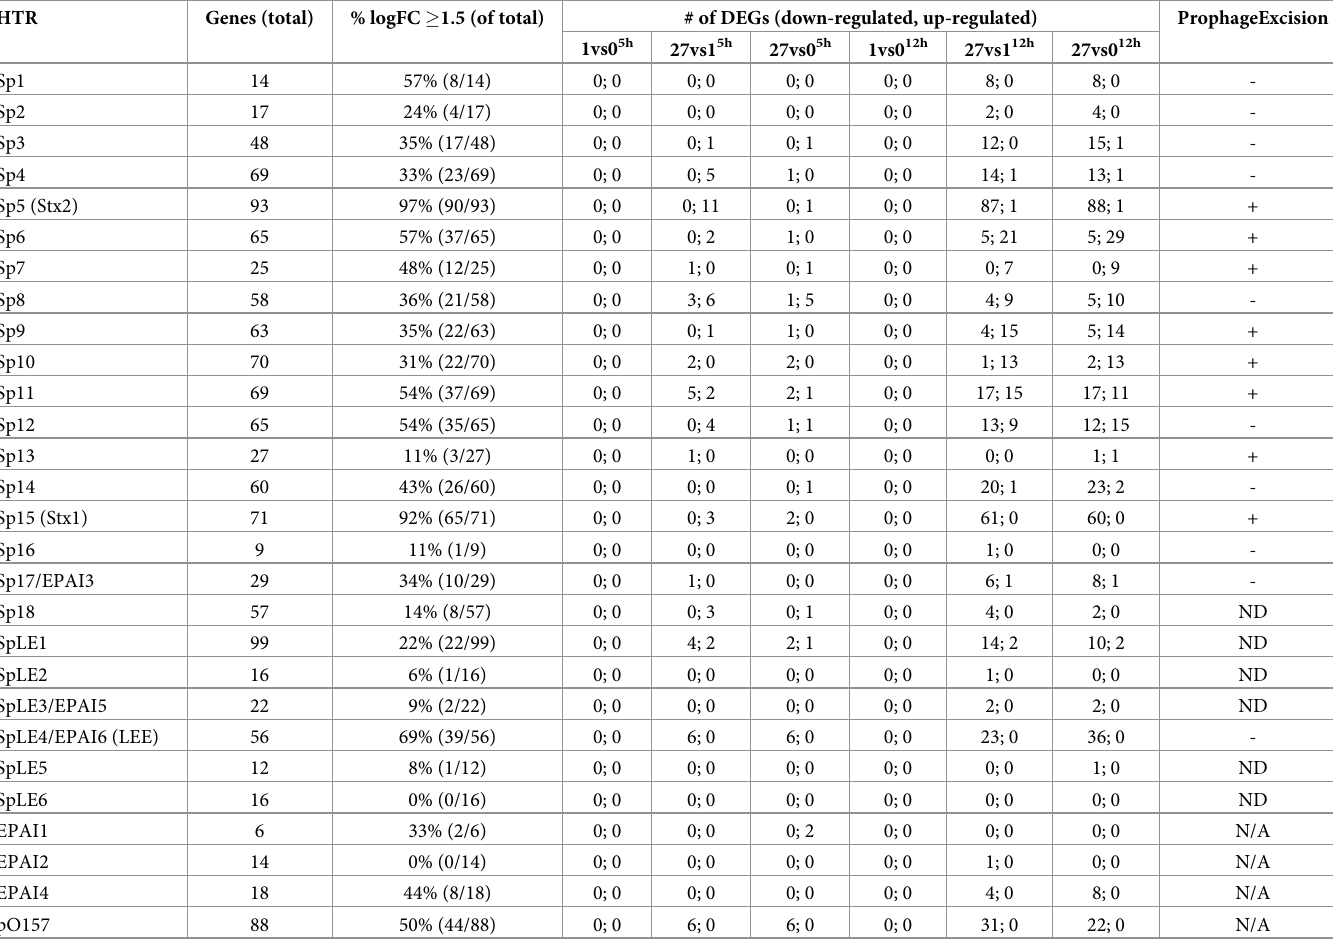
Table 3. The number and percentages of DEG in horizontally-transferred-regions (HTR). The differential expression was derived from RNA-Seq comparisons of sero- type O157:H7 strain PA20 under each designated SMX-TM concentration (0, 1x, and 27x) and exposure-time sample point (five hours or 12 hours). Prophage excision after 12 hours of incubation at 27x antibiotic is indicated as either (+) for excision, (-) for no excision, (ND) not determined, or N/A if not